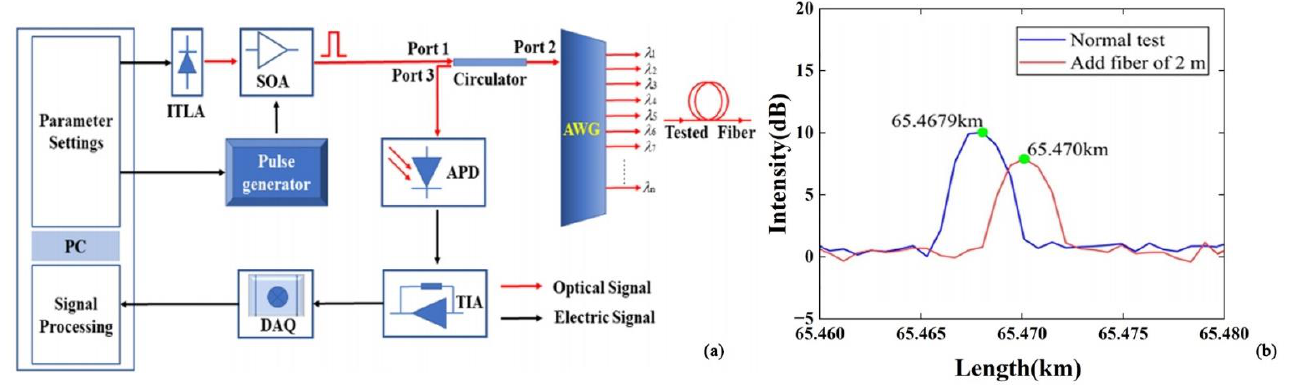
Figure 12. ( a ) Experimental setup. ( b ) The result of spatial resolution measurement [54]. Table 3. Research progress on for spatial resolution enhancement.